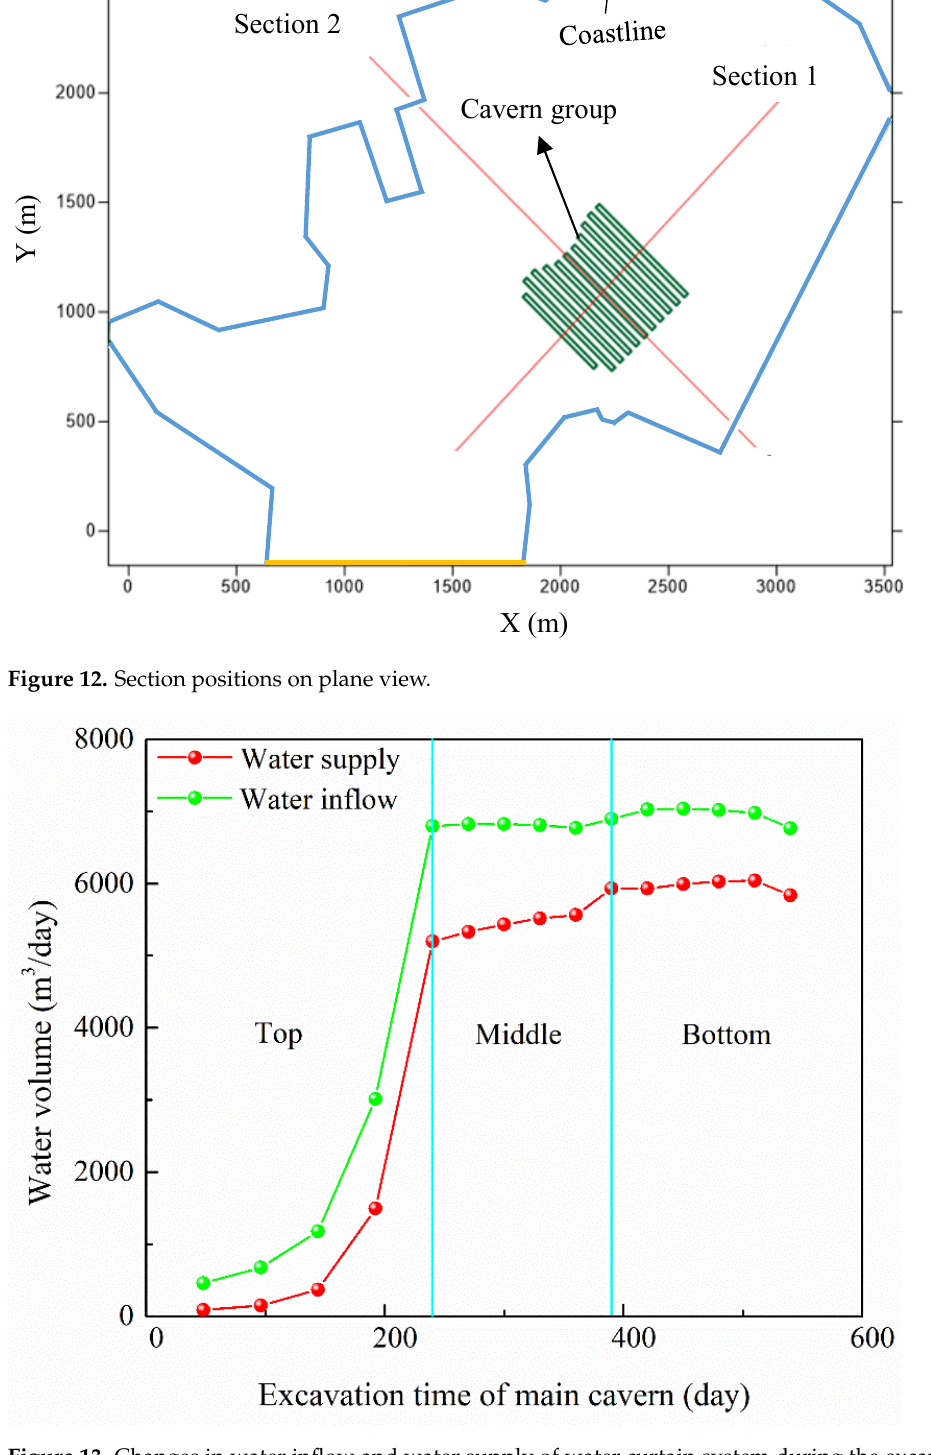
Figure 13. Changes in water inflow and water supply of water curtain system during the excavation of the main cavern.